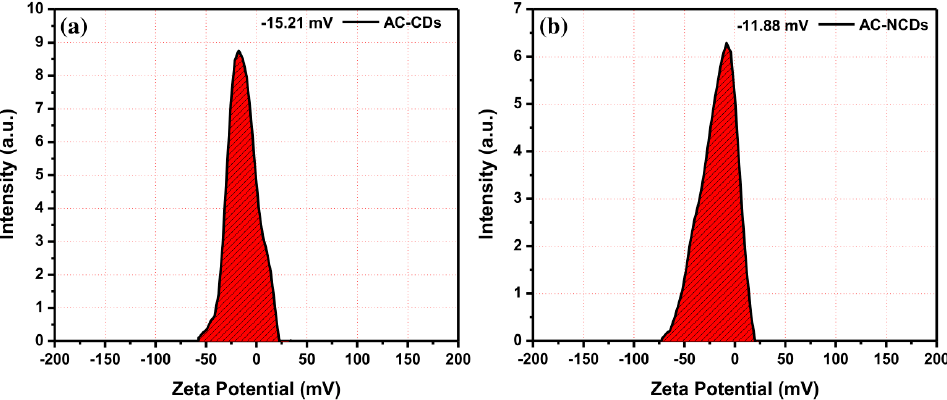
Figure 5. Zeta potential values of ( a ) AC-CDs and ( b ) AC-NCDs.